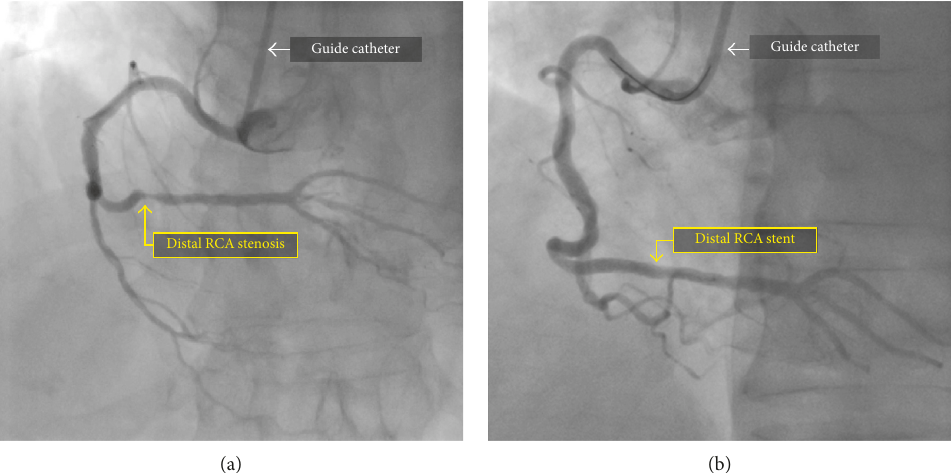
Figure 1: Coronary angiography of the right coronary artery in the left anterior oblique view before (a) and after (b) percutaneous coronary intervention and drug-eluting stent placement.